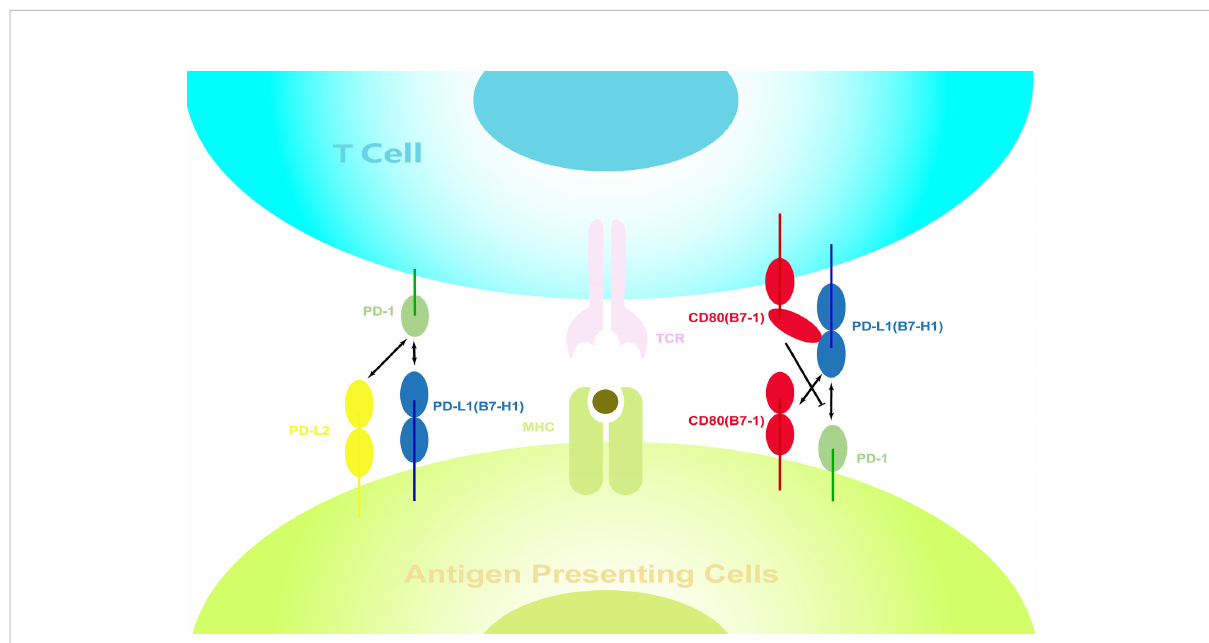
FIGURE 3 Interactions between costimulatory molecules on the surface of immune cells. Interactions between costimulatory molecules, which are expressed on both APCs and activated lymphocytes, form a complex regulatory network. PD-1 can bind to PD-L1 and PD-L2, while PD-L1 can also bind to CD80. However, the cis-PD-L1/CD80 interactions restrict the PD-1